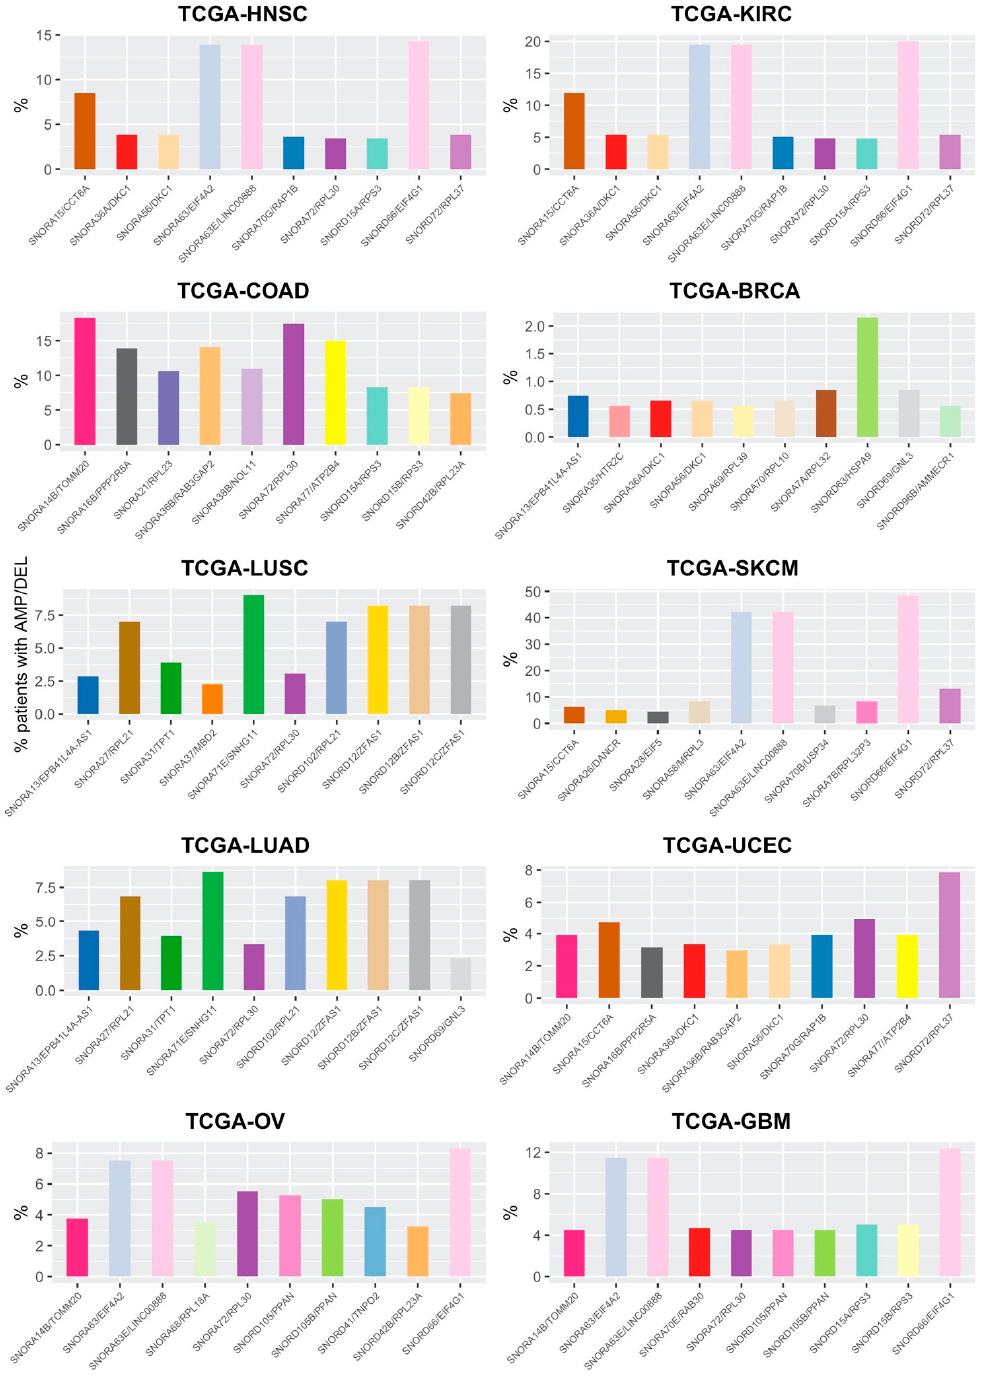
Figure 3. Top snoRNA/host gene couples undergoing CNA in the ten different tumor types. For ease of interpretation, couples recurring in different tumor types have been assigned the same bar colors.